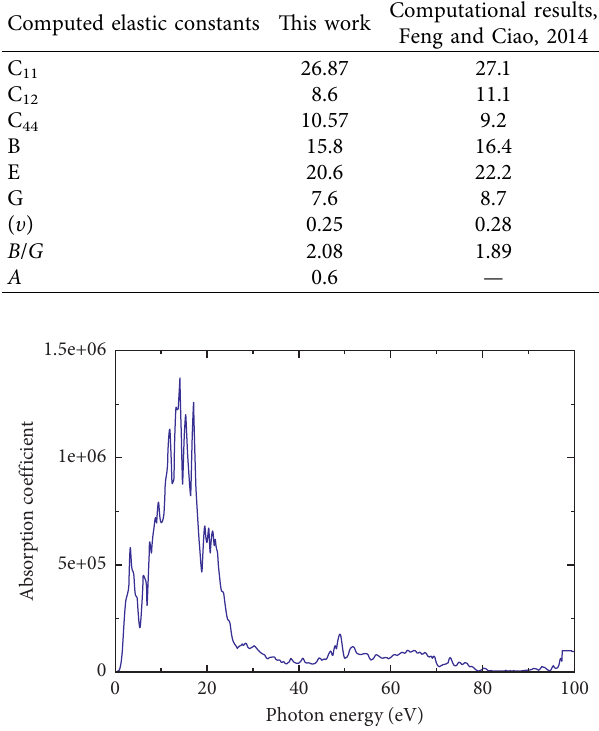
Figure 2: Absorption coefficient against photon